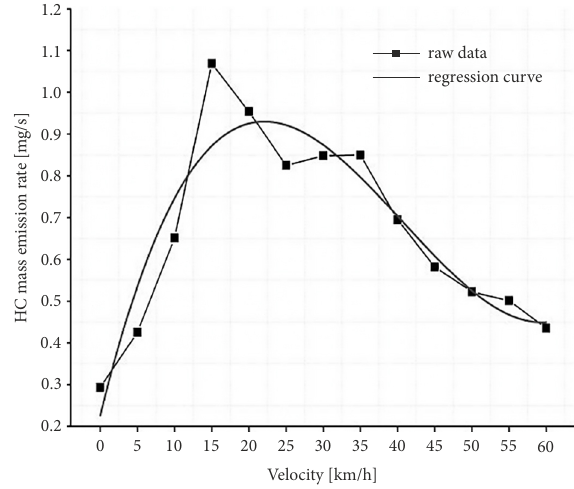
Figure 10. Velocity–emission rate regression curve of HC